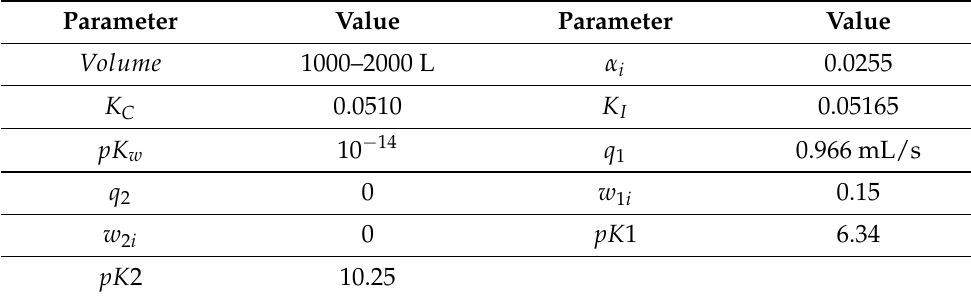
Table 4. Parameters for industrial tests.